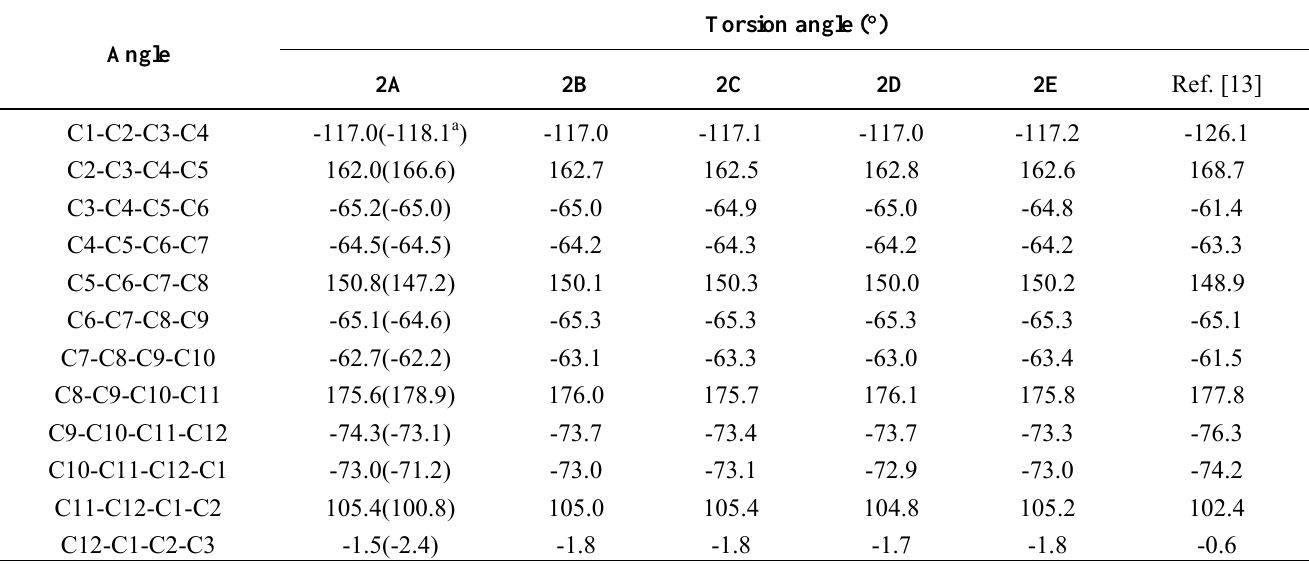
Table 1. The torsion angles of 2A - 2E and 2,3,5,6-bis( ortho -1,10-decylidene)dihydropyrazine.